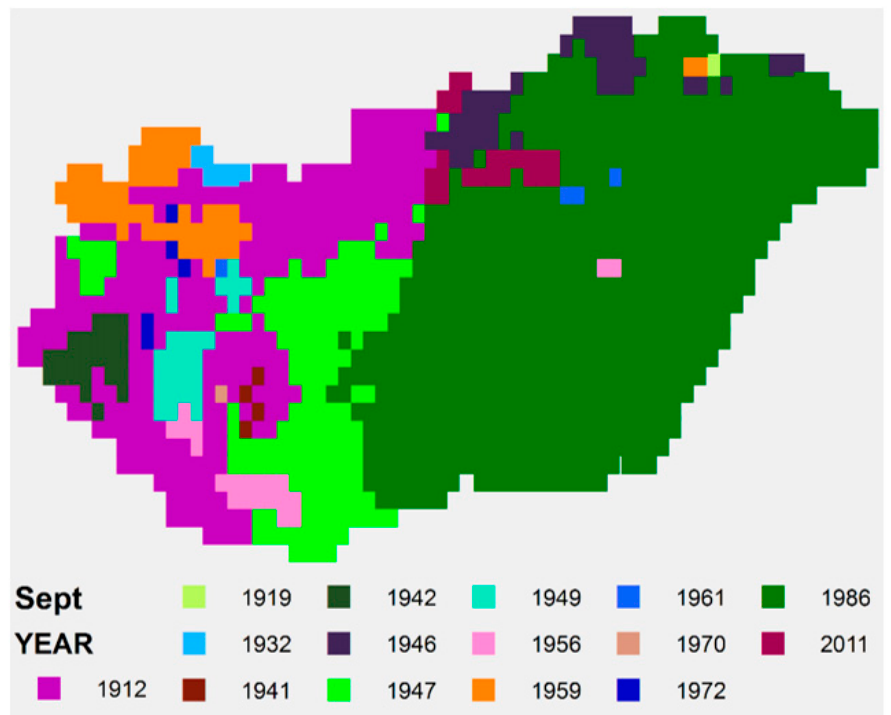
Figure A15. September: Year of maximum SPTI values, 1871–2020.